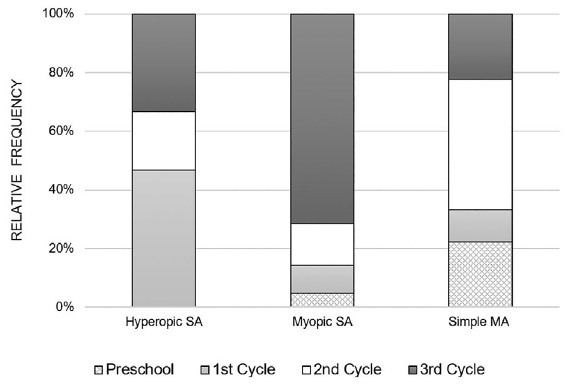
Figure 2. Relative frequency of the variation of the various types of anisometropia, with the school